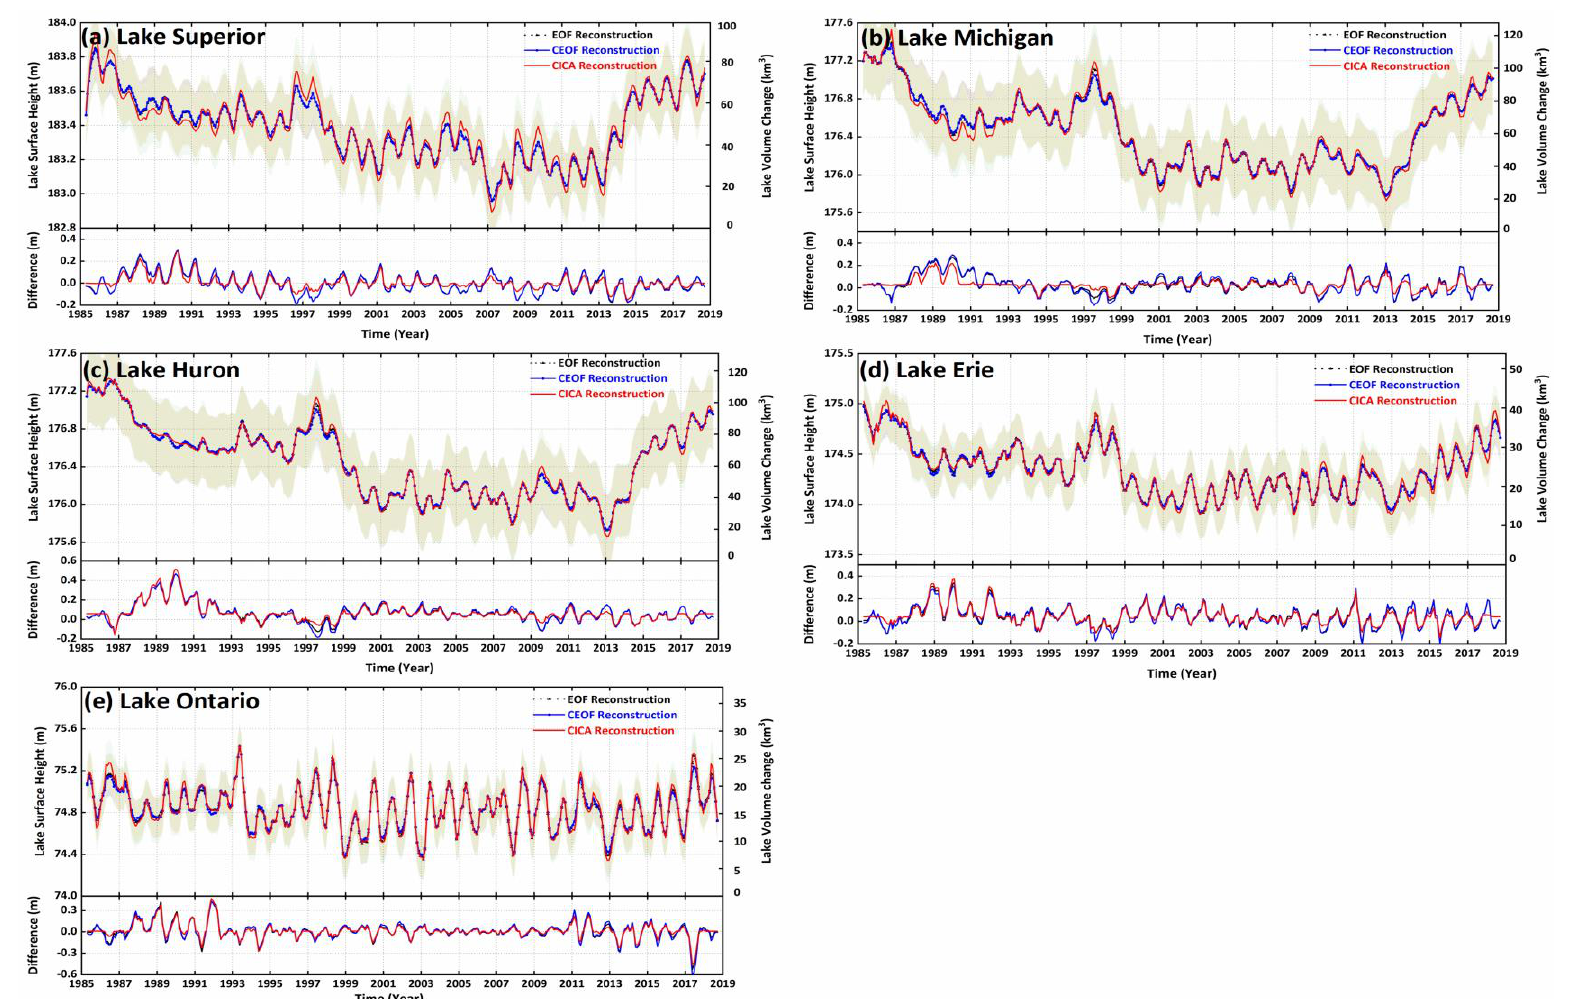
Figure 5. Time series of lake surface height in each lake of the Great Lakes, reconstructed by EOF (black line), CEOF (blue line), and CICA (red line).